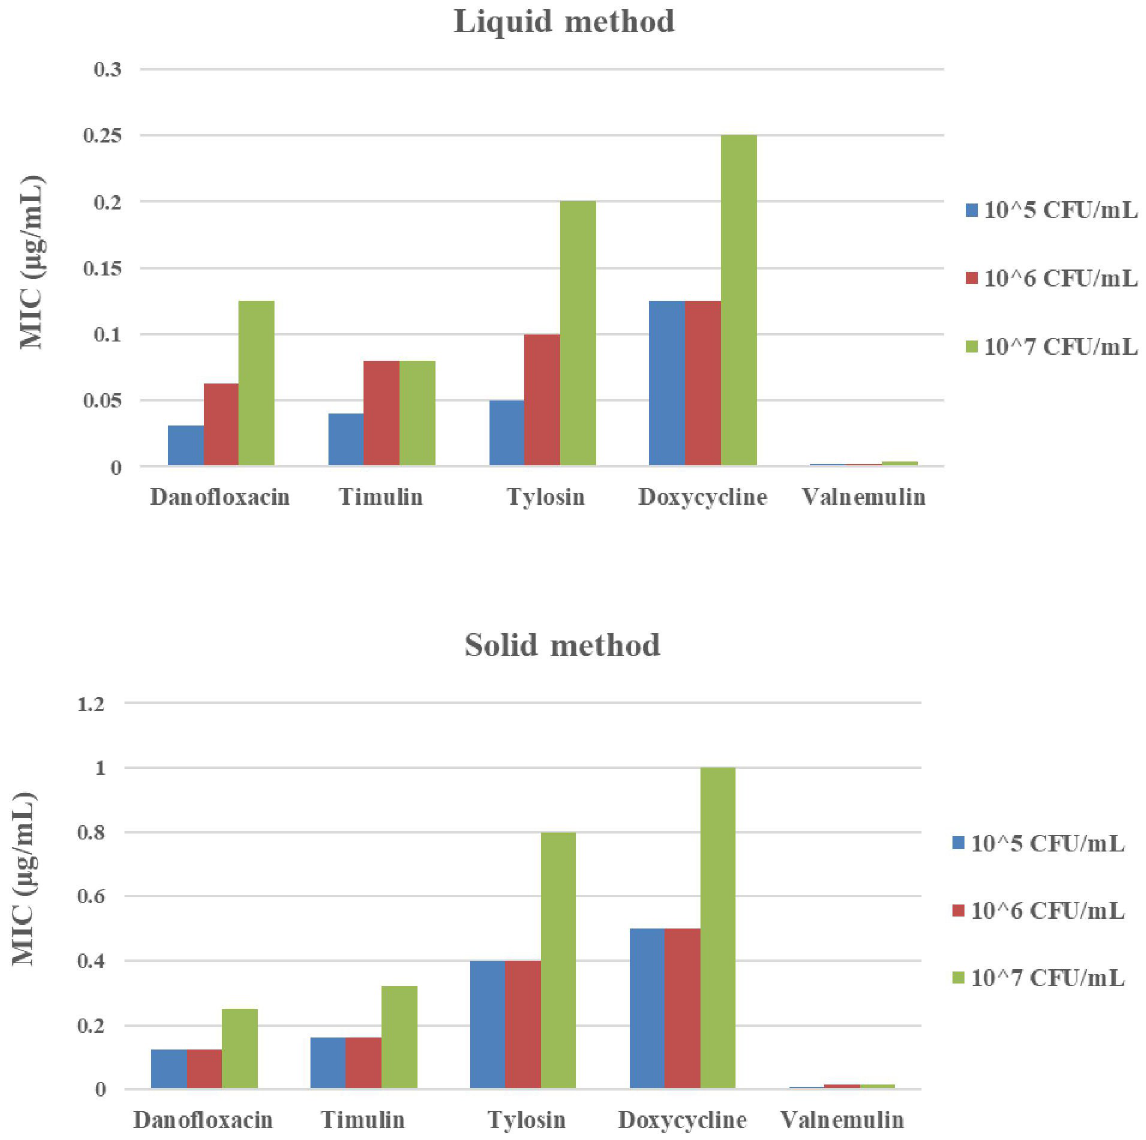
Fig 1. Minimum inhibitory concentration (MIC) determination for danofloxacin, tiamulin, tylosin, doxycycline, and valnemulin against M . hyopneumoniae in artificial medium using liquid and solid agar methods with inoculum sizes of 10 5 , 10 6 , and 10 7 CFU/mL.